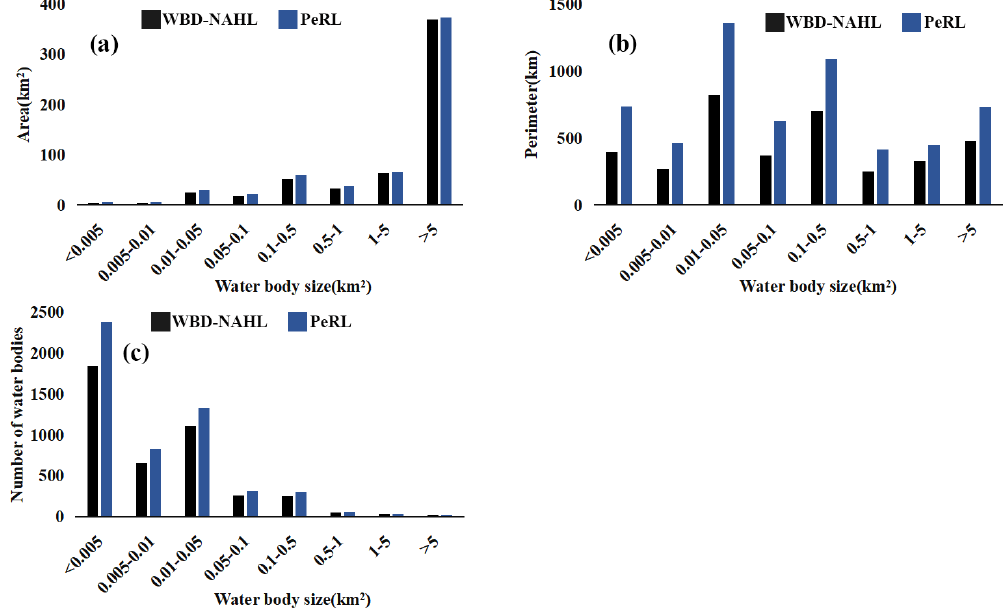
Figure 9. Area, perimeter, and number of water bodies identified by the PeRL and WBD-NAHL datasets.